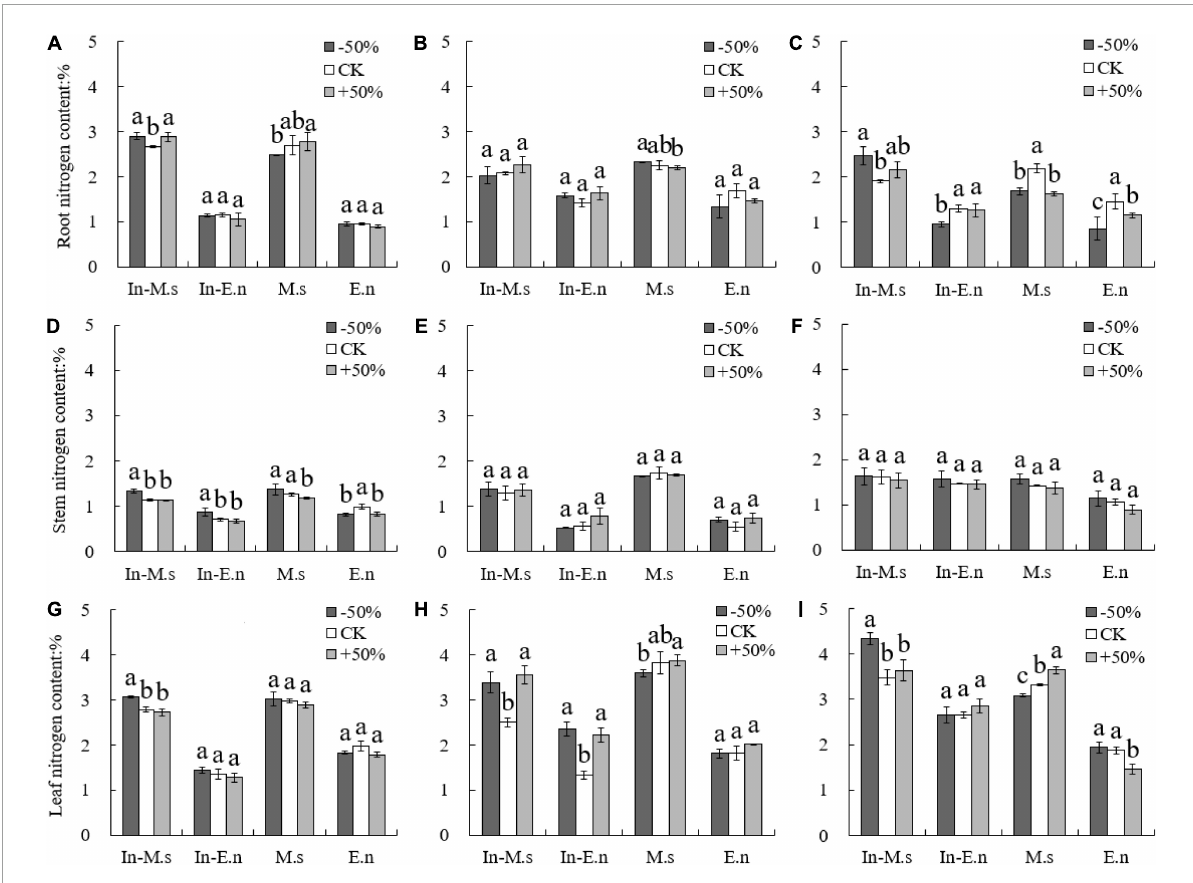
FIGURE4 Effect of water on nitrogen content in roots, stems, and leaves of different forages ( A,D,G : 2015; B,E,H : 2016; C,F,I : 2017). Different lowercase letters show significant differences under different water levels ( P < 0.05).